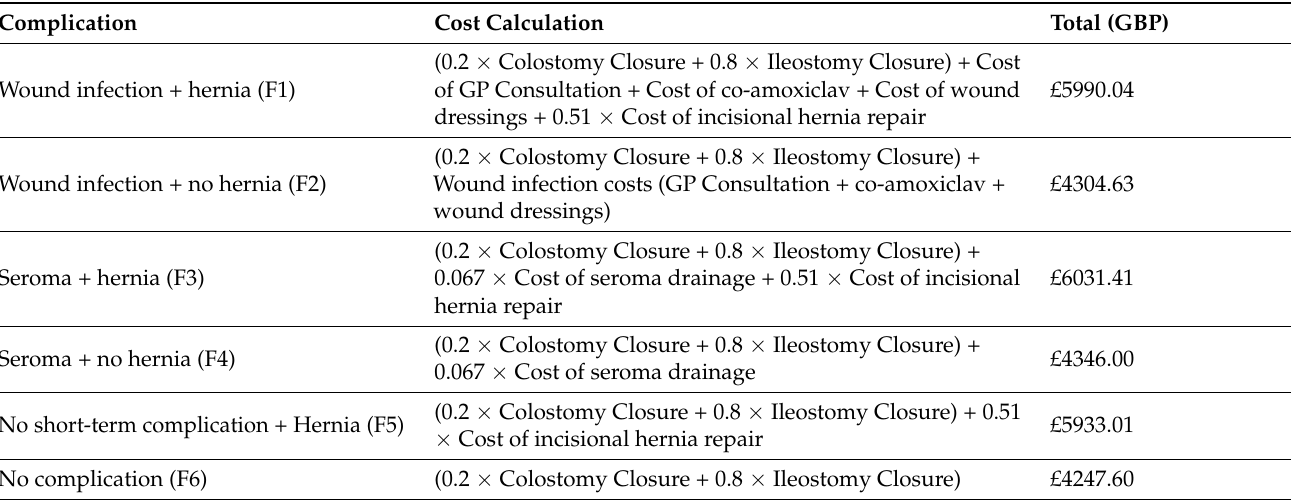
Table A4. Calculations conducted to obtain the total cost associated with each terminal node in the control arm of the decision